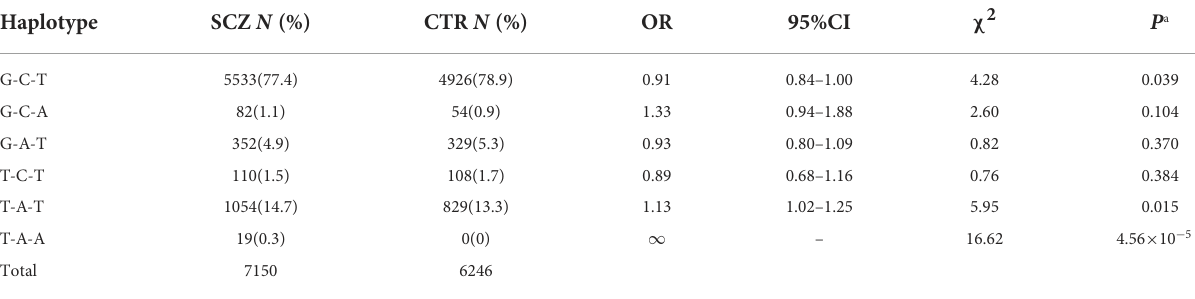
TABLE 7 Haplotypic association of the rs10489202–rs11586522–rs532193193 haplotypes with